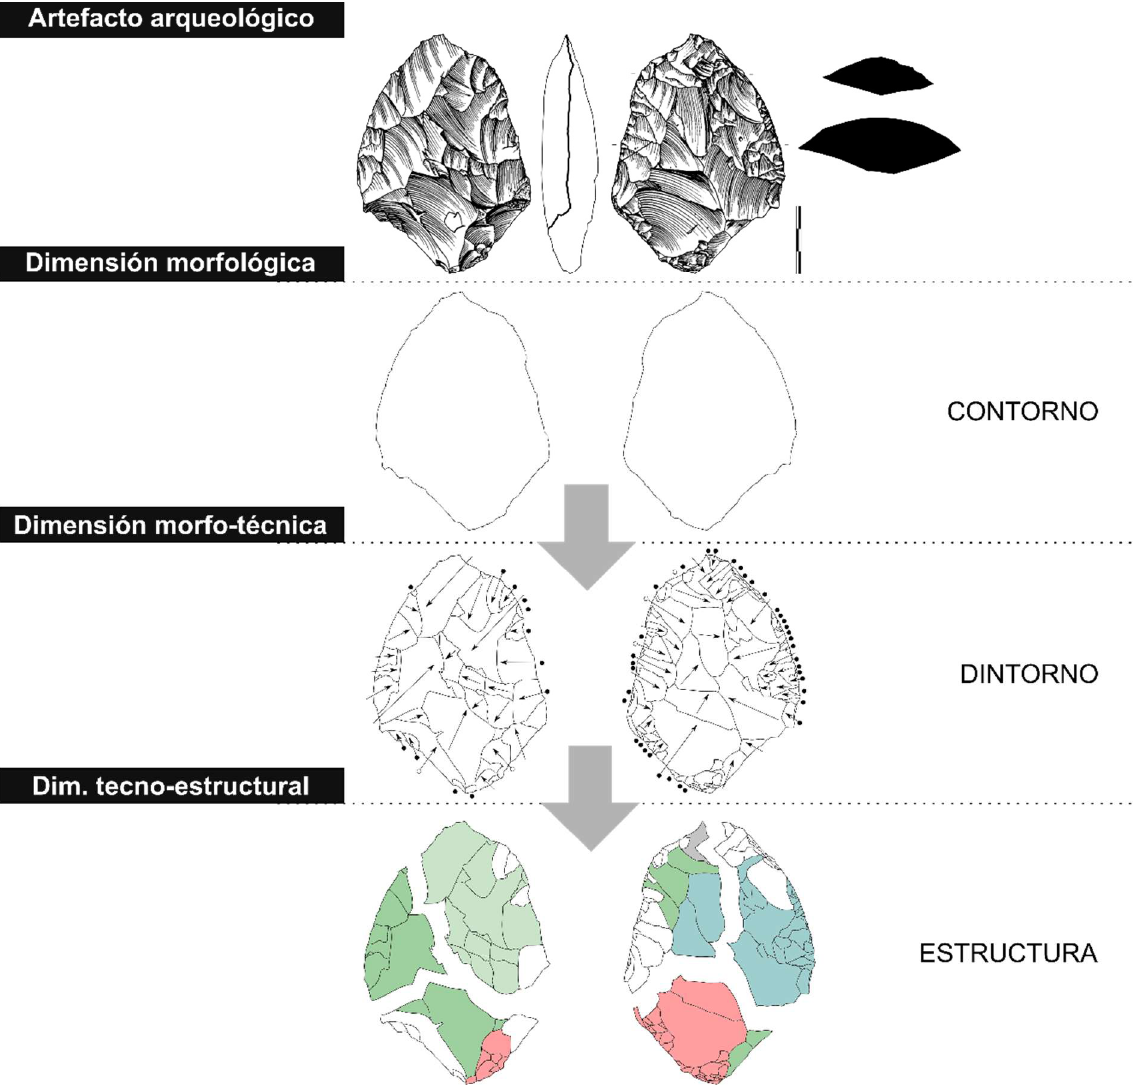
Figura 4. Ejemplo de las diferentes dimensiones analíticas de un artefacto según el enfoque utilizado. Lo que denominamos artefacto corresponde al objeto inmediatamente hallado durante la excavación arqueológica. La tipología mofológica favorece un análisis del contorno de la pieza. Muy a menudo este análisis nos ofrece informaciones pertinentes, pero hay que tener en cuenta que el contorno (o lo que denominamos generalmente como forma) no es más que uno de los tantos criterios técnicos que pueden componer la estructura de la pieza lítica. La tecnología, por su parte, privilegia el estudio de la producción del artefacto, es decir de su dintorno , los procesos de producción contenidos en su contorno y que le han dado forma. Finalmente, la tecnología funcional parte del análisis del dintorno para identificar la estructura del artefacto, así como las zonas funcionales que permiten su funcionamiento